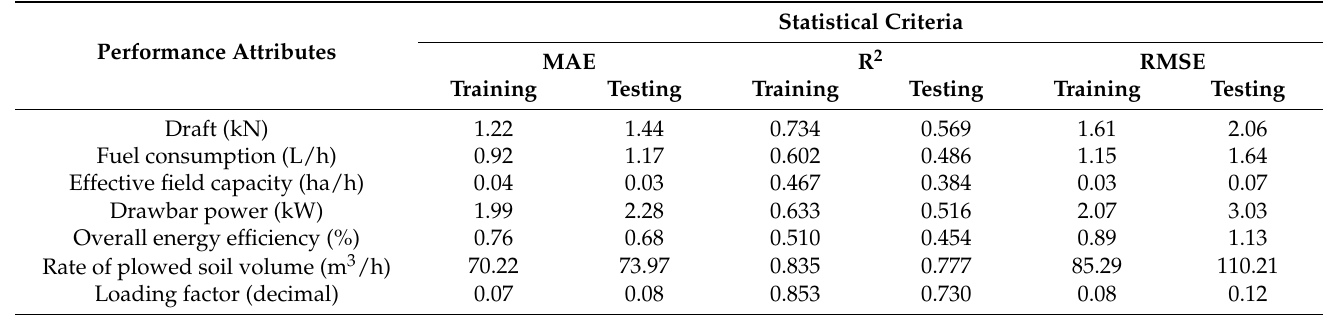
Table 4. Statistical criteria of the established ANN model for prediction of the performance attributes of the tractor-chisel unit during soil-tillage process in the case of the testing and training datasets.